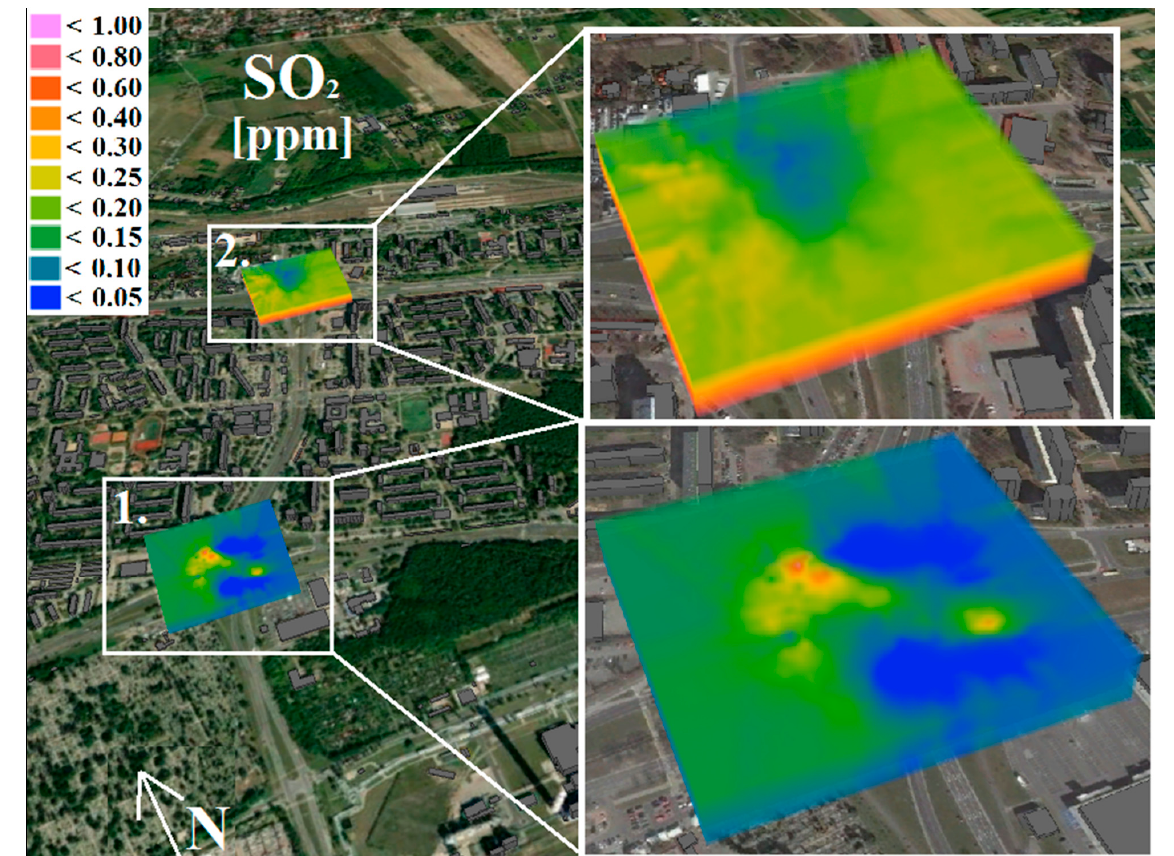
Figure 12. Spatial distribution of SO 2 concentration for a selected location in the vicinity of EC-4.